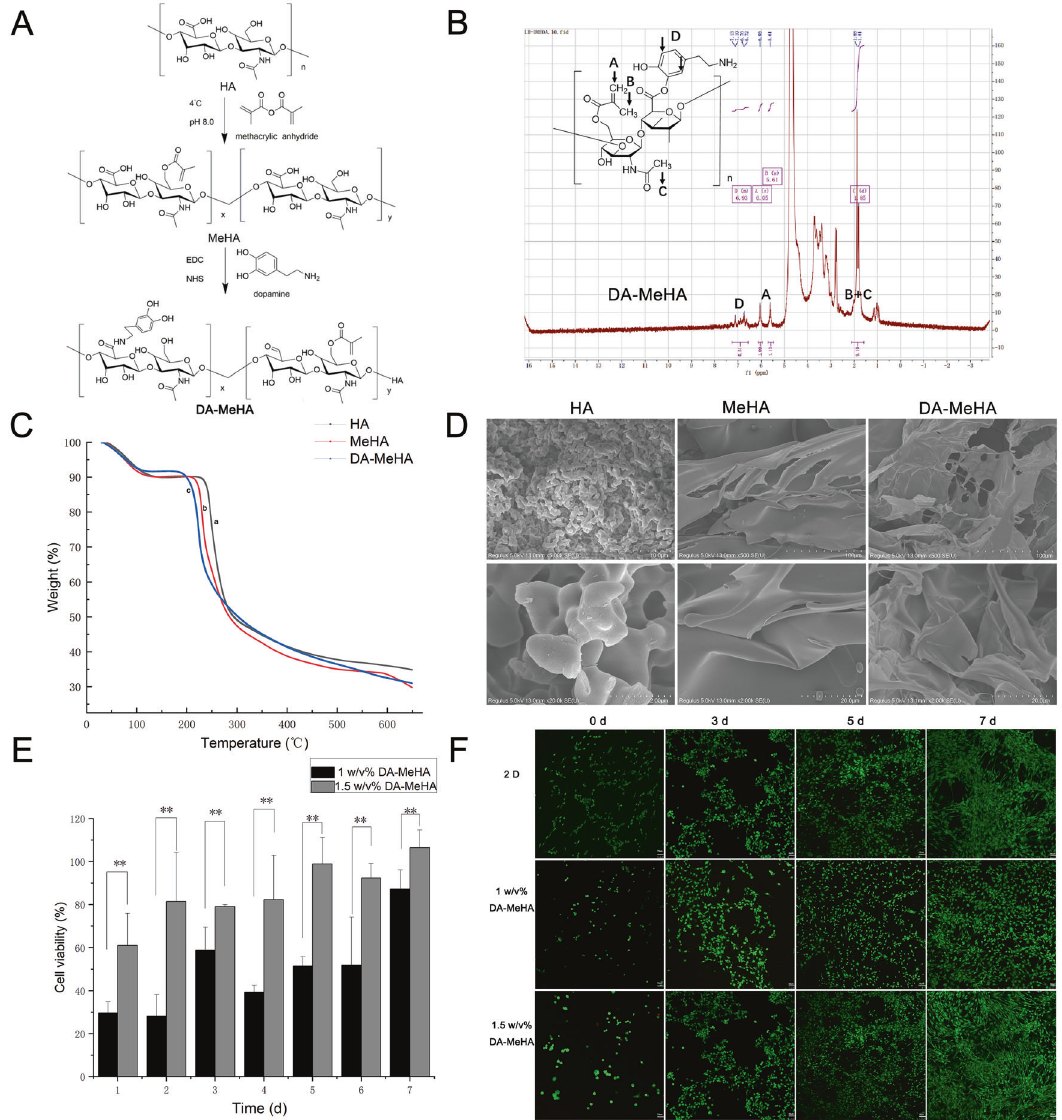
Fig. 2 DA-MeHA synthesis, characteristics and biocompatibility. A The DA-MeHA synthesis process. B 1 H NMR spectrum of DA-MeHA. C TGA thermograms of HA, MeHA, DA-MeHA and their blends with a temperature increase rate of 20 °C/min. (a) gray line — HA, (b) red line — MeHA, and (c) blue line — DA-MeHA. D SEM images of HA, MeHA and DA-MeHA. HA formed crystal-like structures while MeHA and DA-MeHA formed similar porous leaf-like structures. E , F CCK-8 assays and live/dead staining showed that the DA-MeHA hydrogel provides a biocompatible 3D culture environment for encapsulating ADSCs in vitro (* p < 0.05 and ** p <